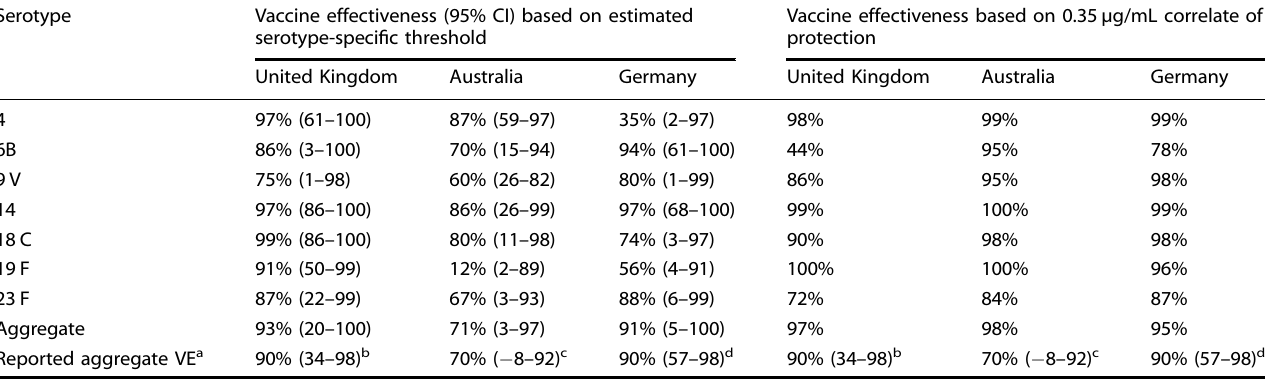
Table 5. Predicted serotype-speci fi c vaccine effectiveness for the PCV7 serotypes in PCV13: Estimations using serotype-speci fi c protective threshold compared to the estimations using pan-serotype 0.35 µg/mL correlate of